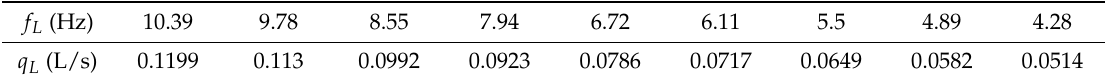
f )-Flow ( q ) calculating data of fiber turbine flow sensor in the nonlinear Table 3. Frequency ( Table 3. Frequency ( f L )-Flow ( q L ) calculating data of fiber turbine flow sensor in the nonlinear range. L L range. f L (Hz)